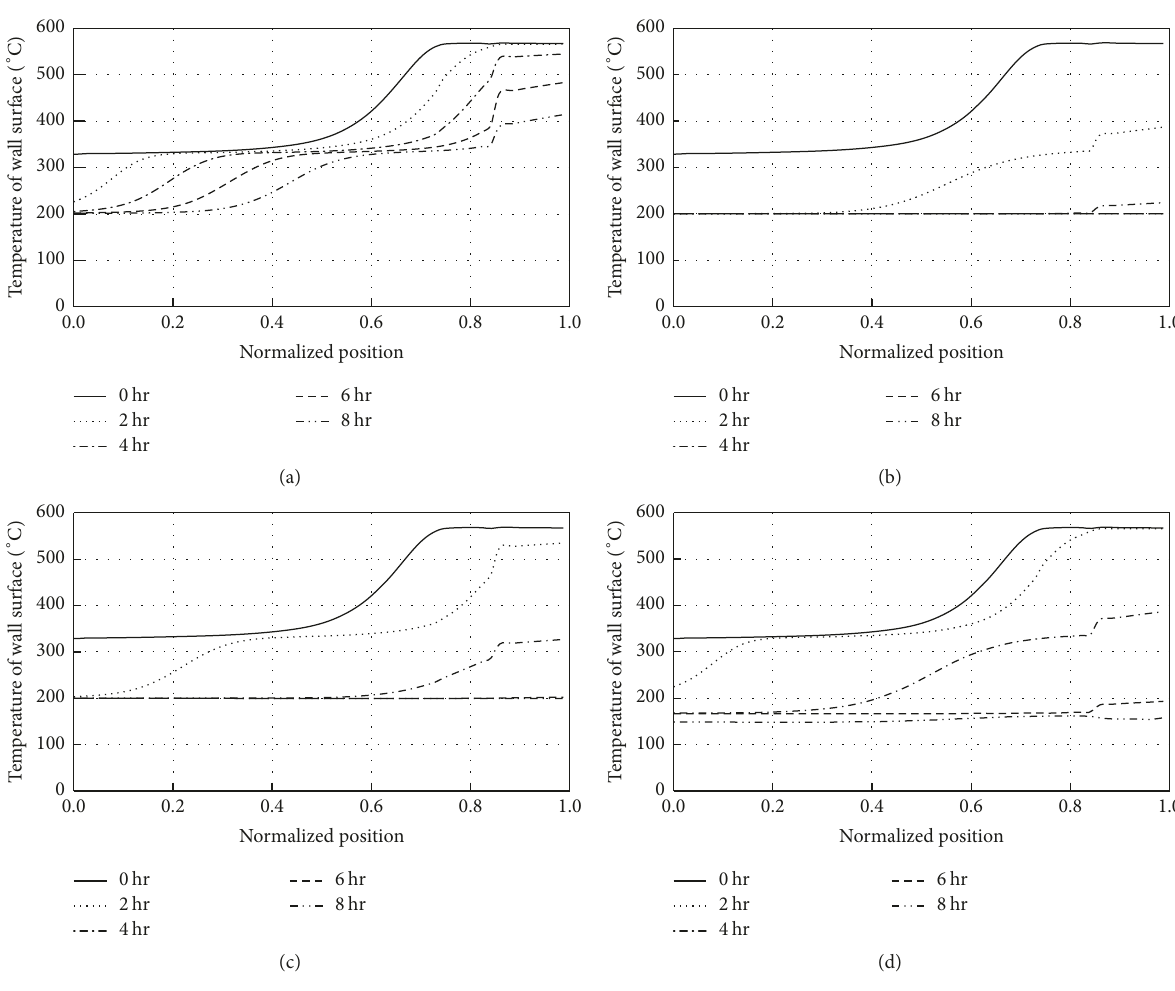
Figure 7: Temperature distribution of SGHT and LP during precooling